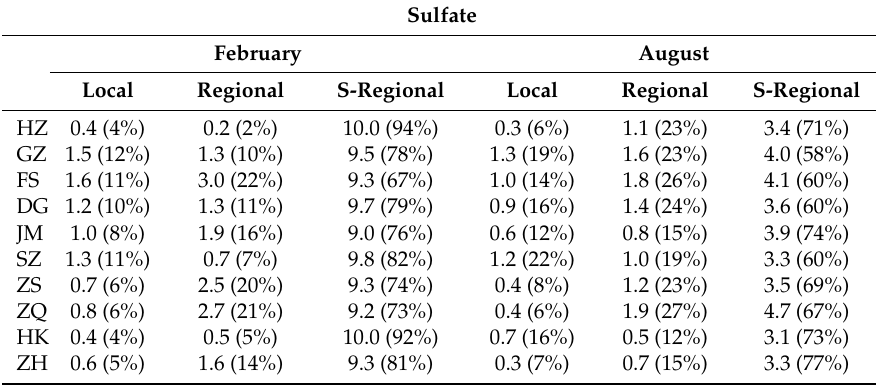
Table 3. Local, regional and super-regional contribution of sulfate and nitrate in 10 cities over the PRD region (in µ g/m 3